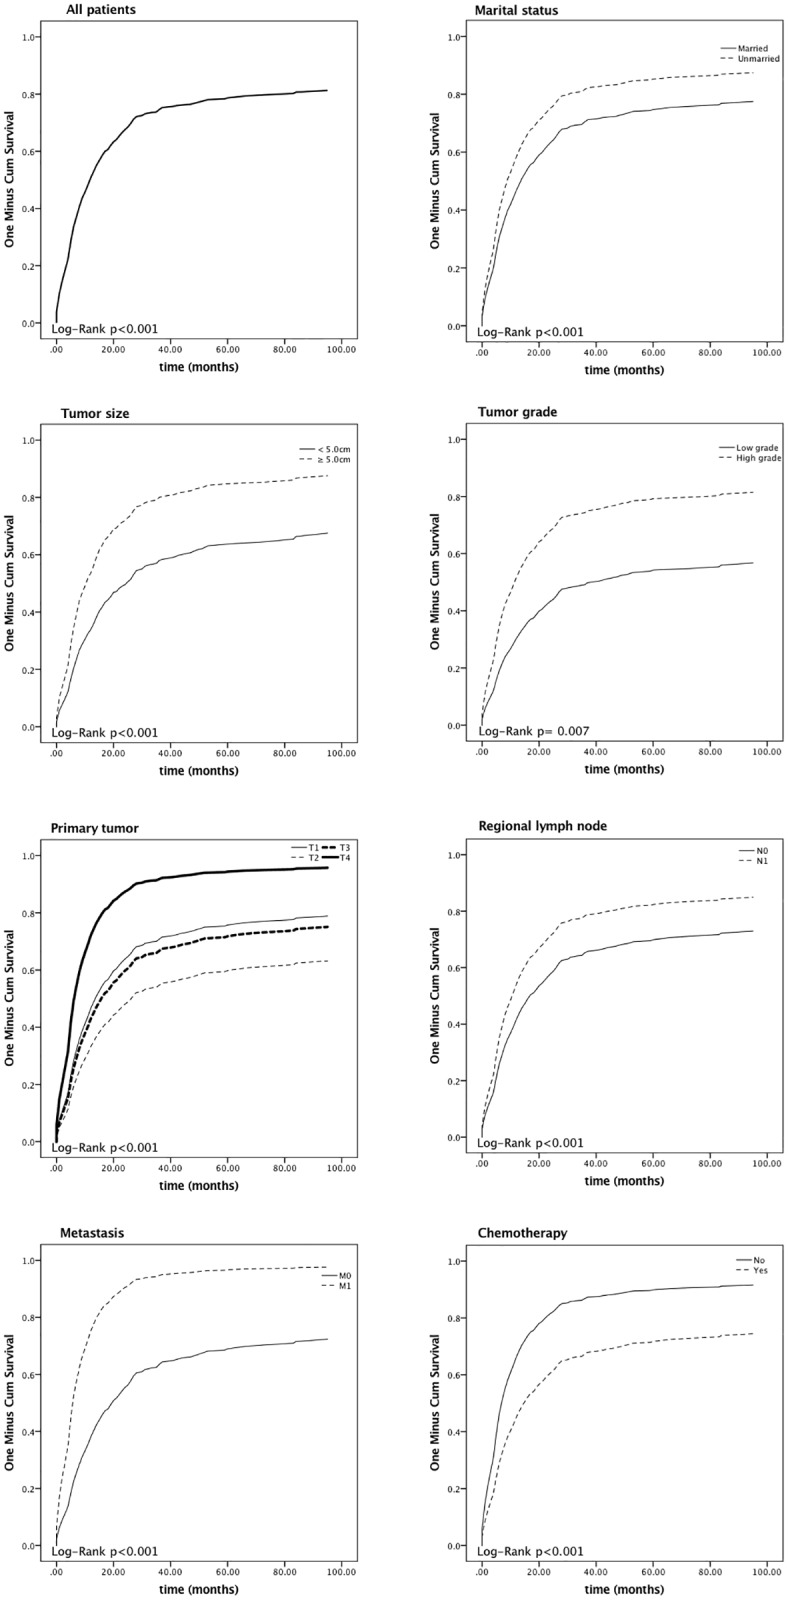
Kaplan—Meier survival curves of all patients and patients stratified by various factors.